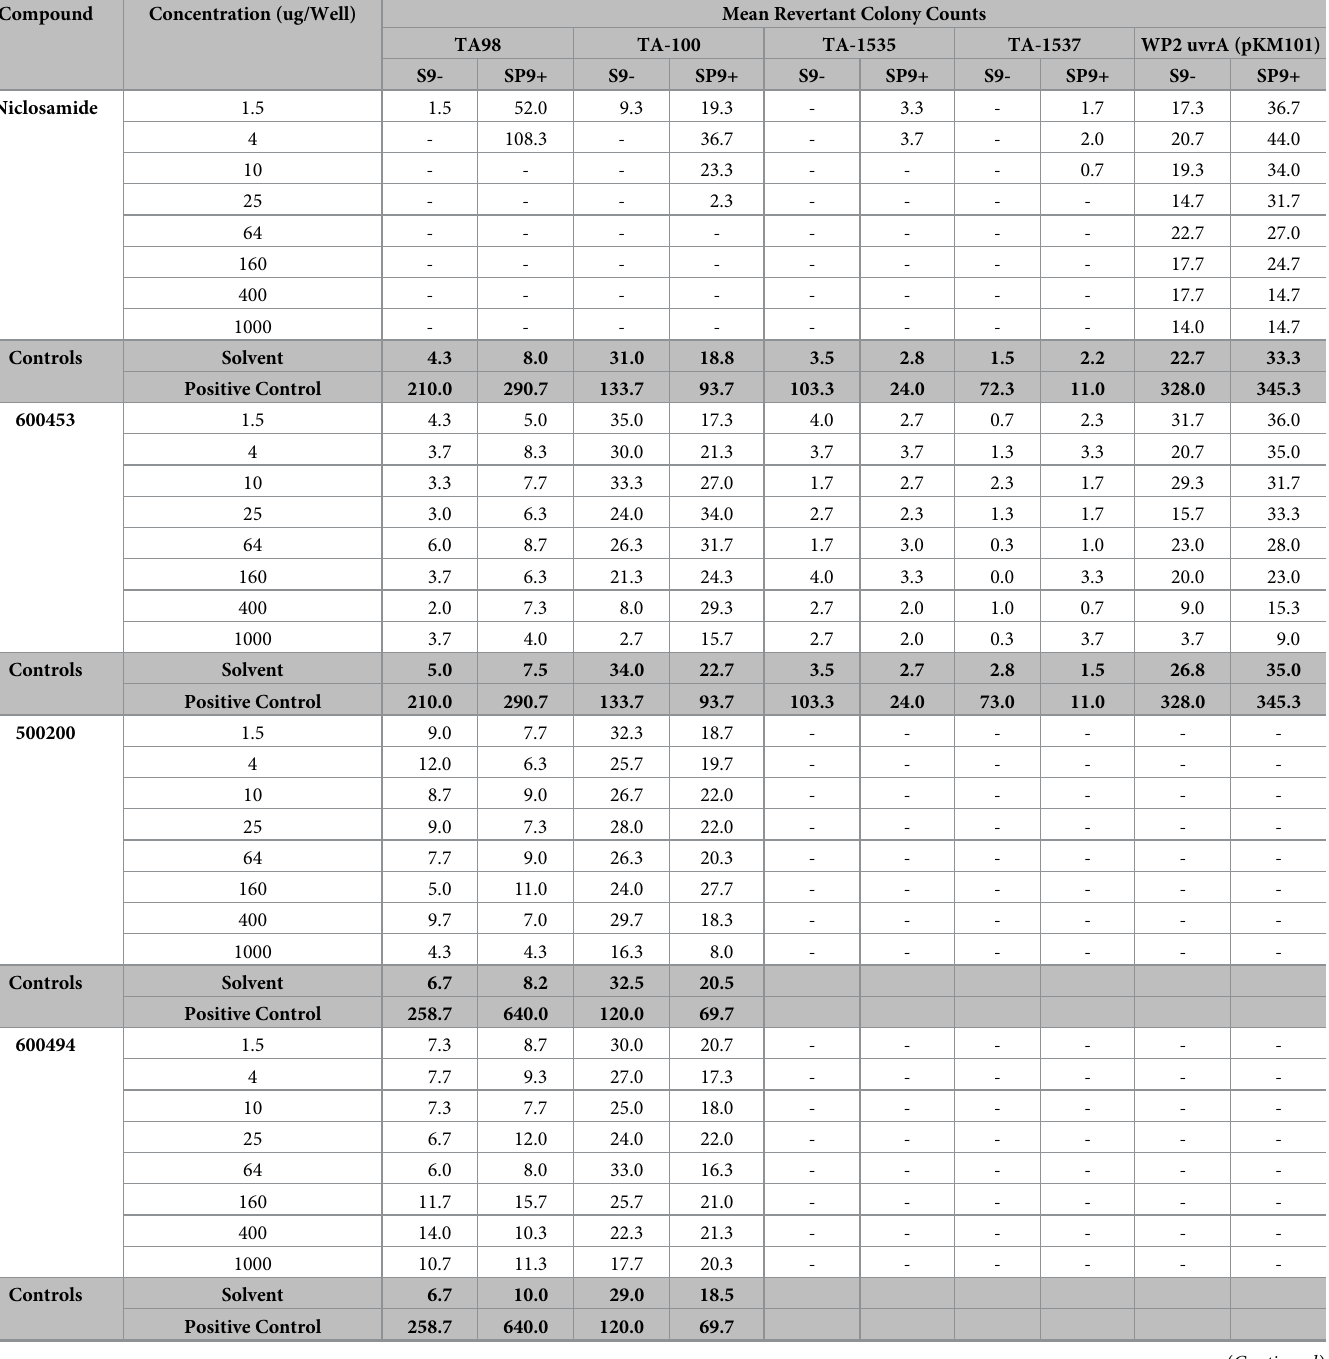
Table 3. Mutagenicity of niclosamide and N-substituted phenylbenzamides using the Ames assay. The values shown represent the mean number of revertant colonies in the presence and absence of exogenous metabolic activation (Aroclor 1254 induced rat liver S9) from 3 replicate wells. The positive control chemicals were 2-Aminoan- thracene (2-AA) for all S9 activation experiments, 2-nitrofluorene (2-NF 2) for TA98, SA for TA100 and TA1535, ICR-191 for TA-1537 and MNNG for WP2 uvrA. � indi- cates compounds that exhibit statistically significant increases in mean revertant colonies (p < 0.05) as indicated by the Ames assay. Compound